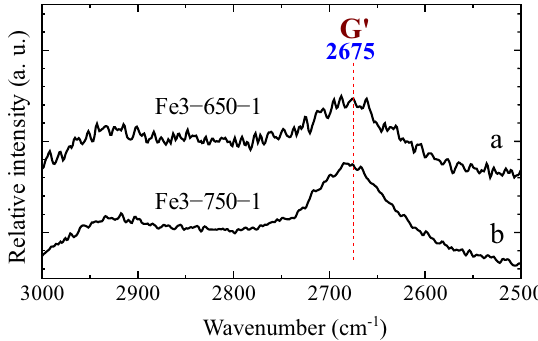
Fig. 4 Raman spectra with a lower-wavenumber G ʹ -band of Fe3-650-1 and Fe3-750-1 charcoal samples: a , Fe3-650-1; b ,